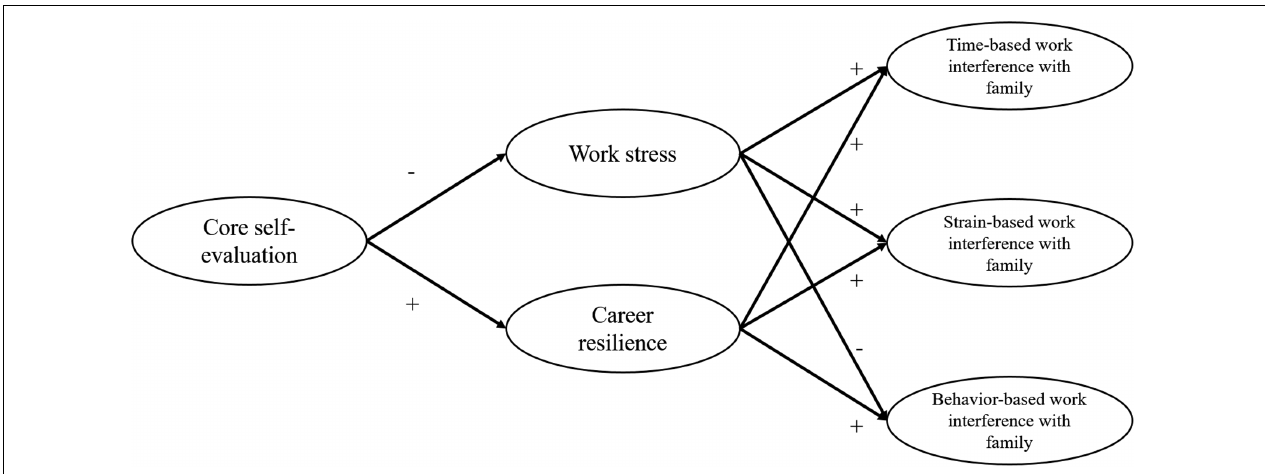
FIGURE 1 | Proposed research model. The first proposed mediation path was from core self-evaluation to three dimensions of work interference with family via work stress. The second proposed mediation path was from core self-evaluation to three dimensions of work interference with family via career resilience.